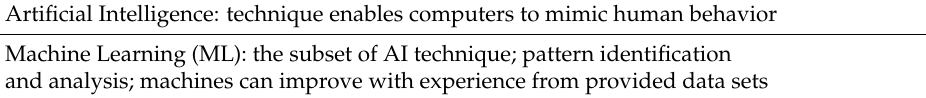
Table 5. Subfields of Artificial Intelligence [89].